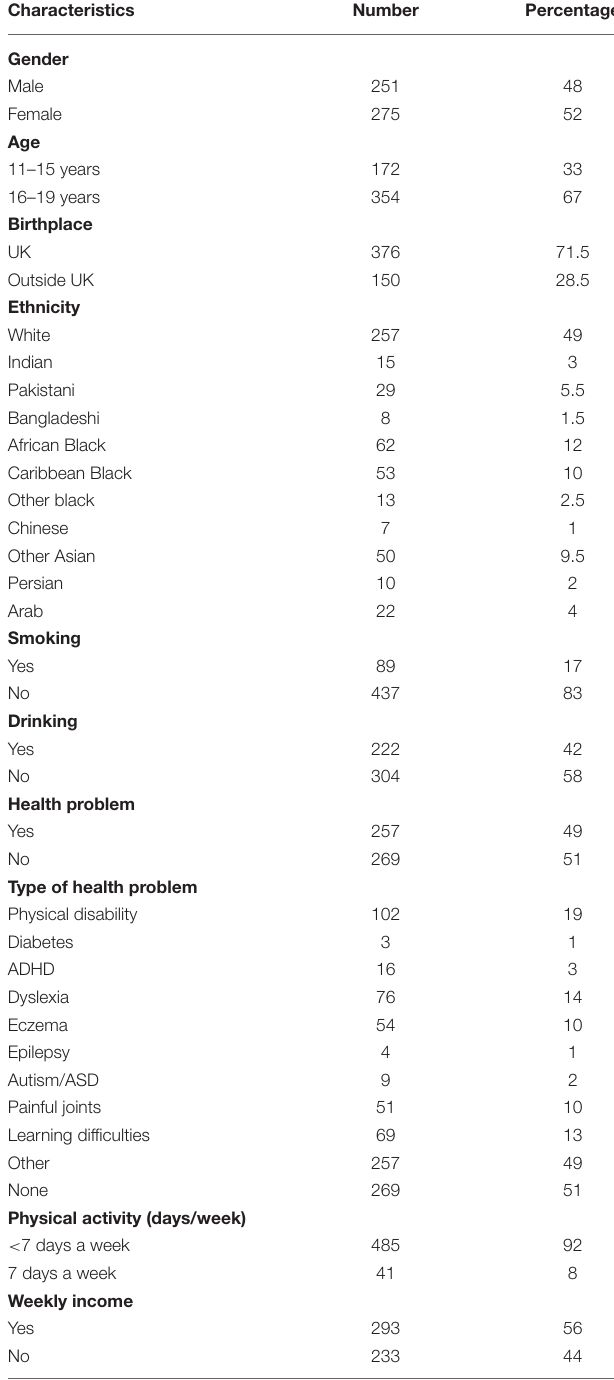
TABLE 2 | Demographics of study